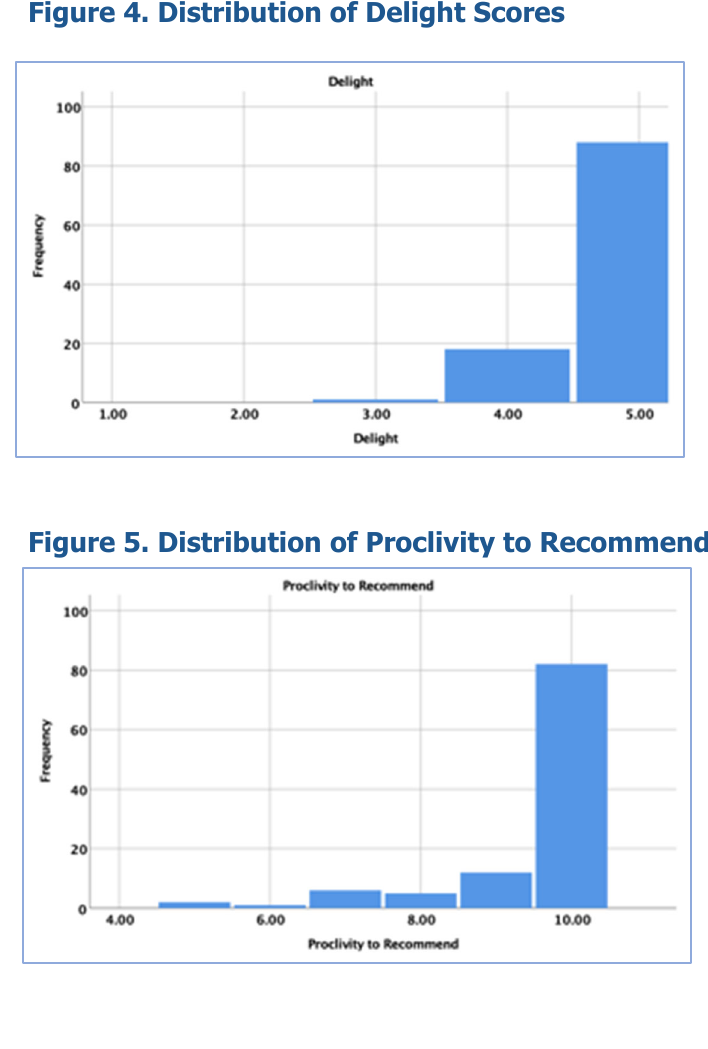
Figure 4. Distribution of Delight Scores